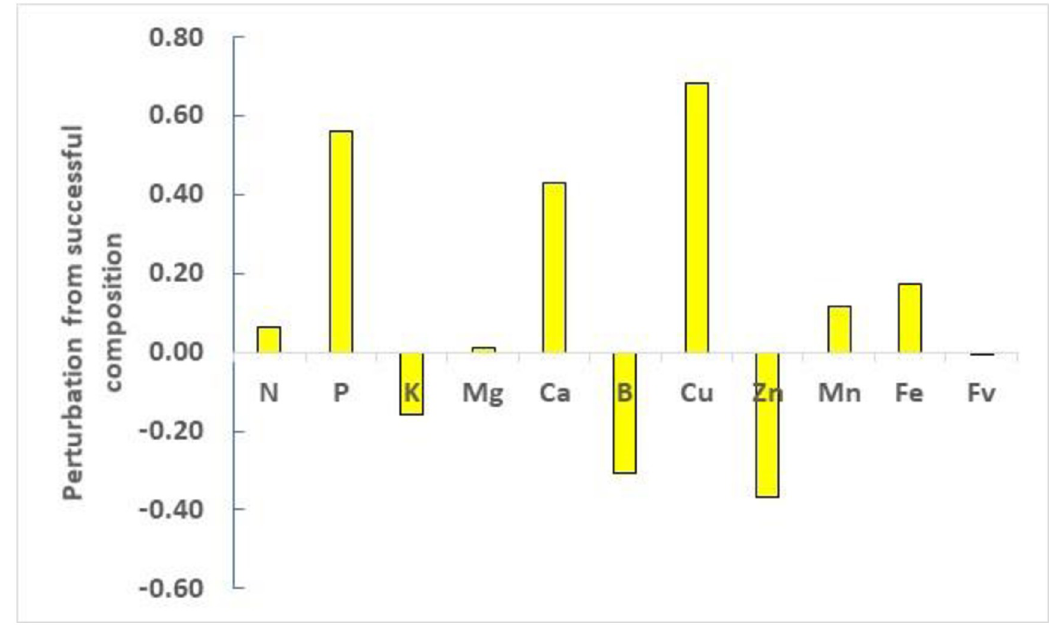
Fig 5. Perturbation vector of the defective Quebec specimen in Table 4 compared to a close successful specimen to attain high yield in the following year.